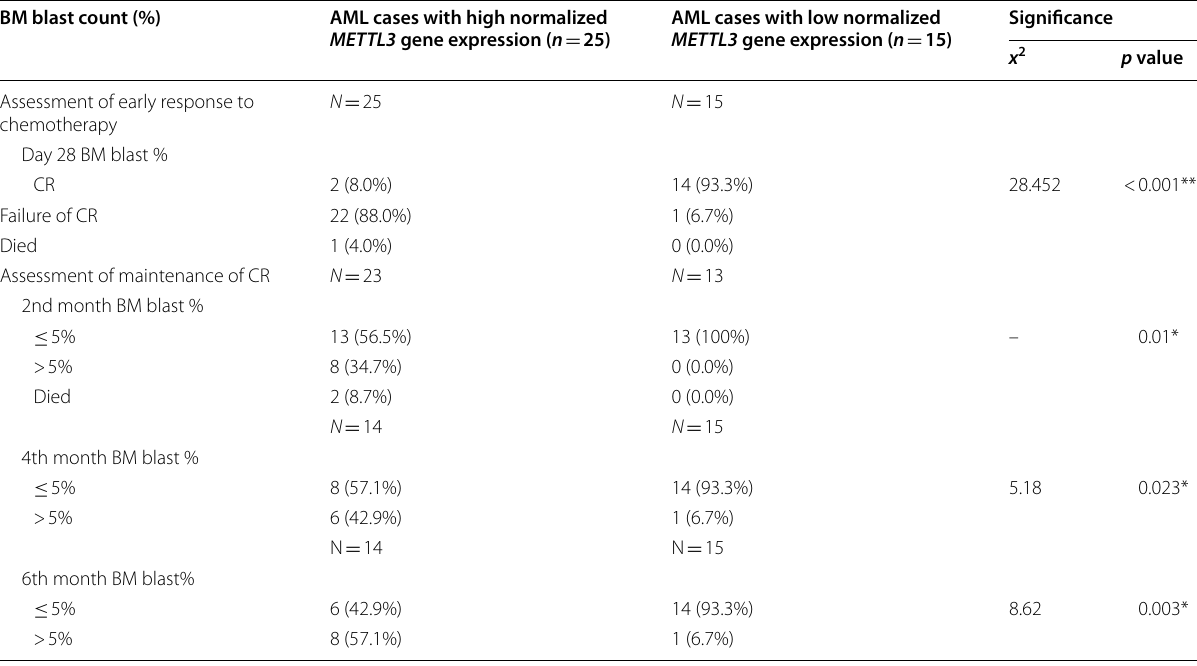
Table 6 Comparison between pretreatment METTL3- based AML regarding of BM blasts in follow‑up samples from day 28 chemotherapy till the end of the 6th month of chemotherapy